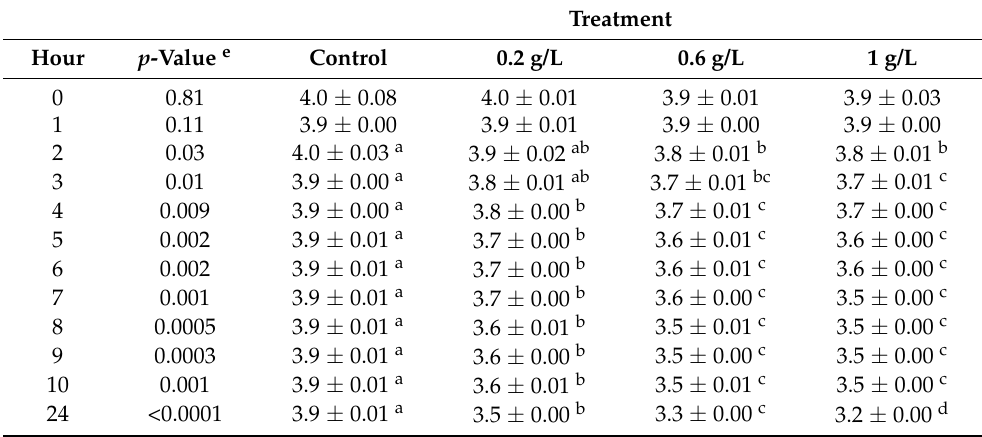
Table 1. Initial pH values over the first 24 h.